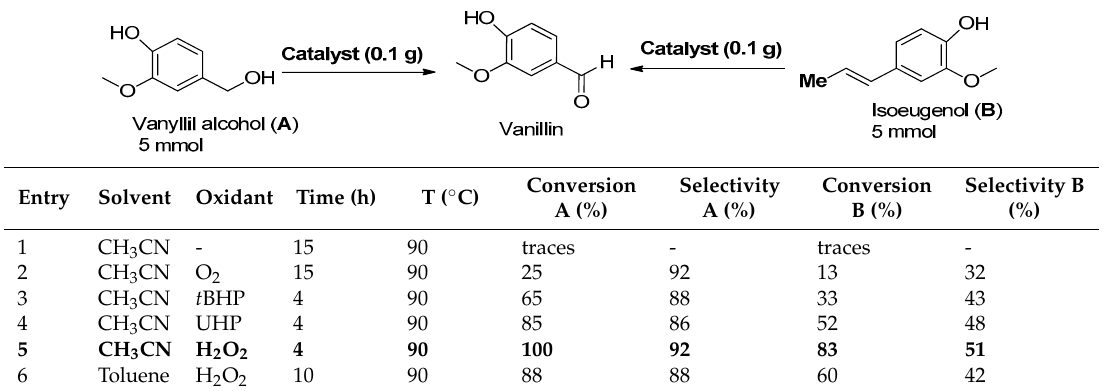
Table 3. Catalytic oxidation of isoeugenol [a ] . (In bold: best catalytic system).